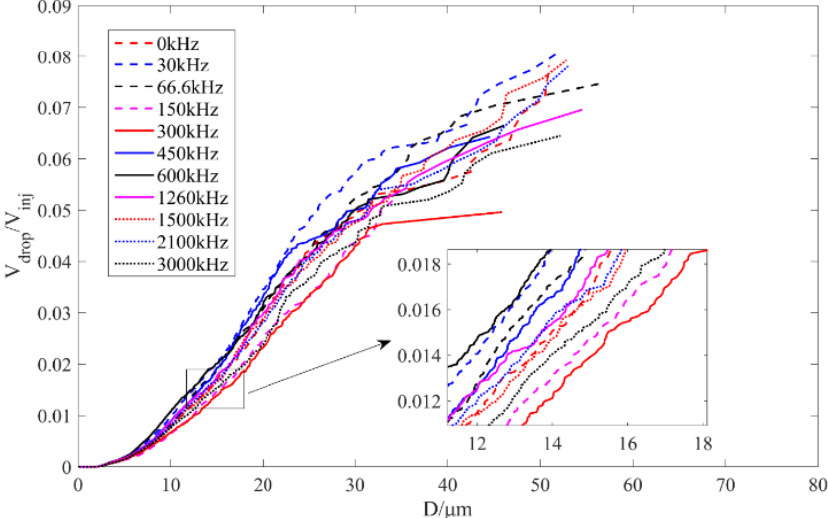
Figure 14. Cumulative density function of atomized liquid fraction.